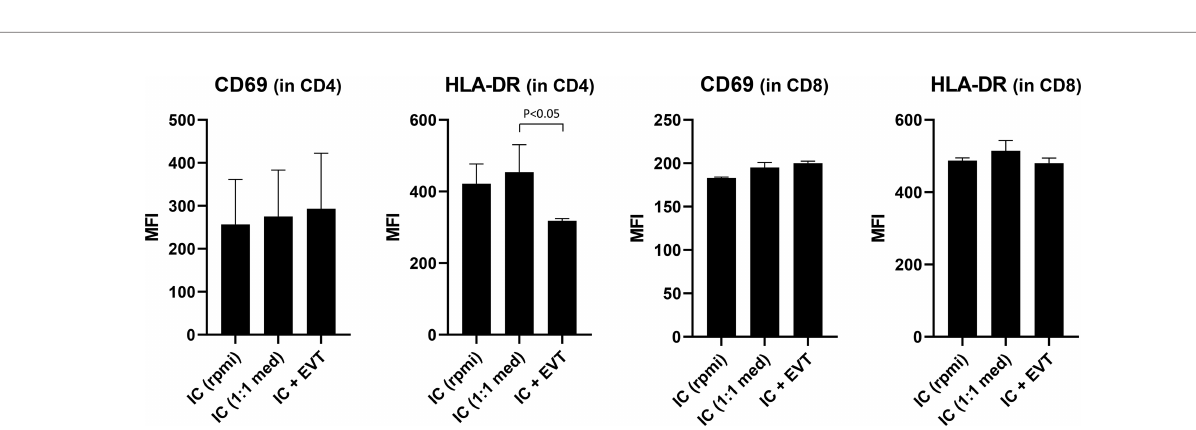
FIGURE 8 | Expression of activation markers on CD4 + and CD8 + T cells following co-culturing of lymphocytes with EVT. First, EVT (culture QH1) were differentiated for six days. Then, lymphocytes from four different donors were added to the EVT for three days. HLA-DR and CD69 were studied by fl ow cytometry in both the CD3 + CD4 + and CD3 + CD8 + T cell population, both in the absence of EVT ( fi rst two columns) or in the presence of EVT (third column). The graph shows means with SEM. *P <